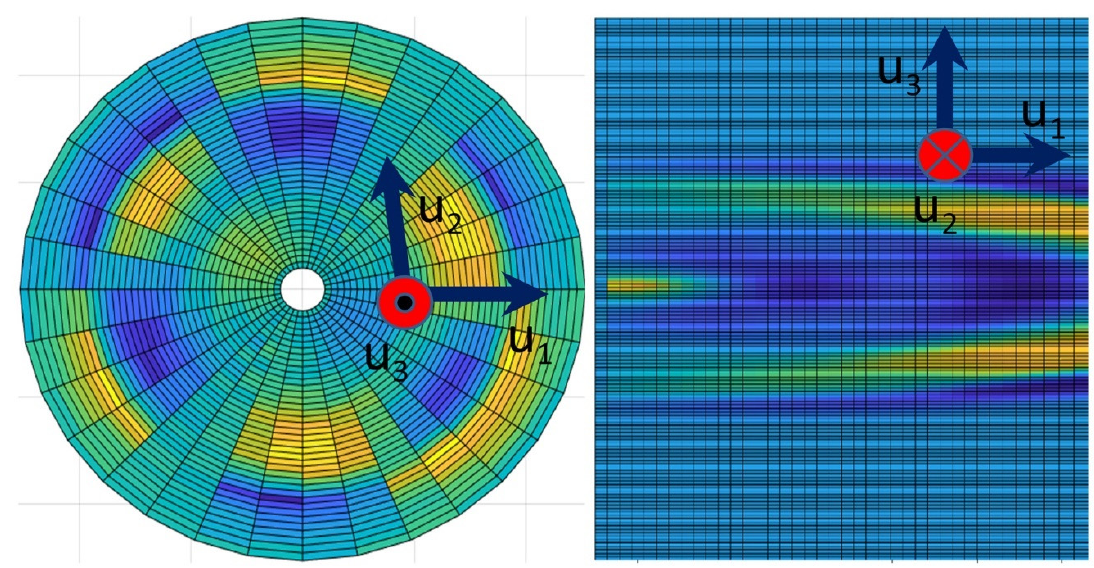
Figure 5. Contour of radiated power in mesh sections u 3 = constant and u 2 = constant , at a given time instant.